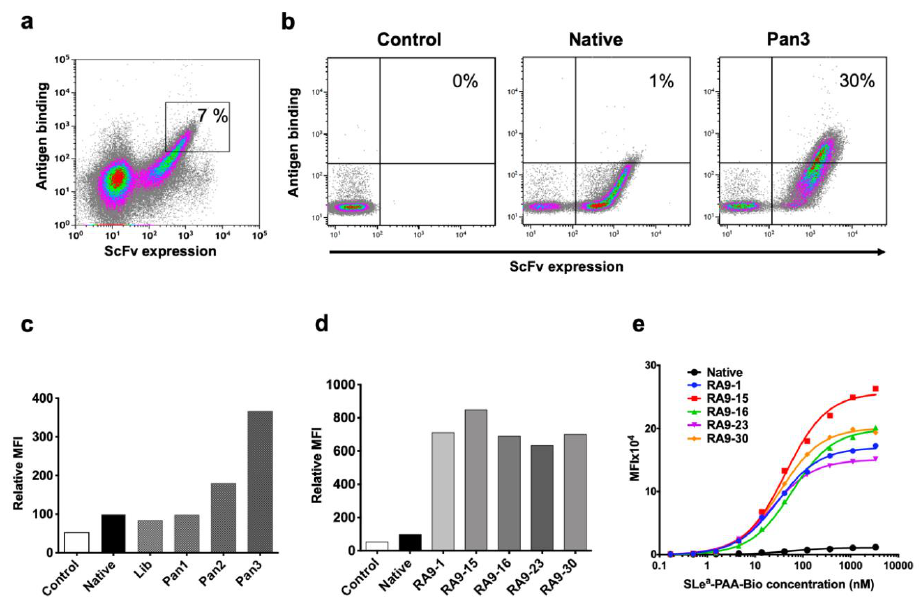
Figure 2. YSD library in vitro affinity maturation. ( a ) First cycle of FACS sort panning and